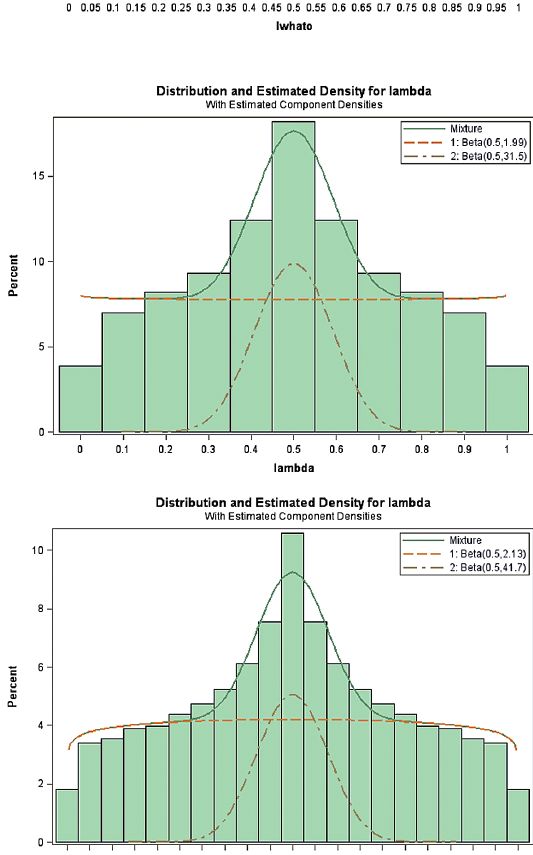
Fig. 6. Histograms for the 1990 Syracuse, NY, census block surface partitioning eigenvalues Left (a): 3-beta distributions fit. Right (b): 2-beta distributions fit. Bottom (c): a single simulated realization of the estimated 2-beta distributions finite mixture model.